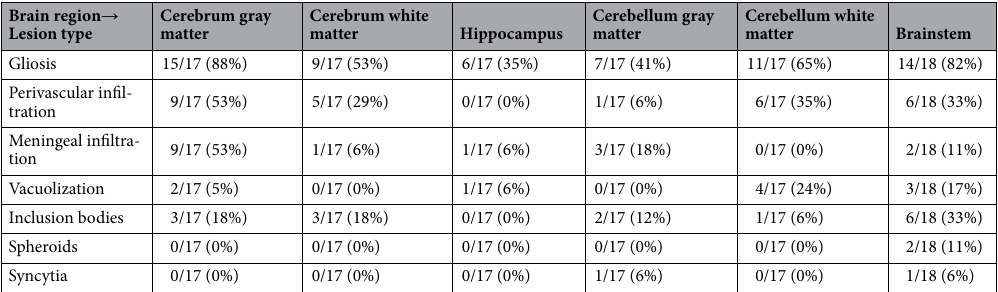
Table 1. Distribution of histologic lesion types identified in infected foxes in different brain